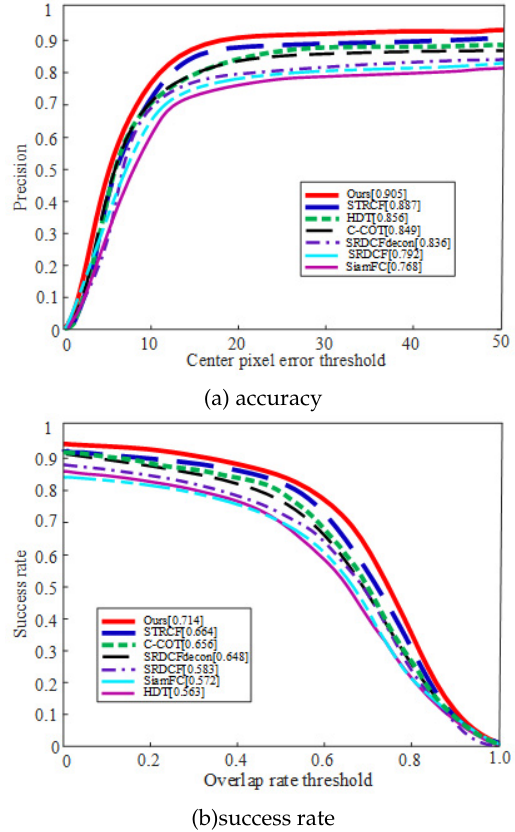
Fig. 5. Comparison curve of average accuracy and average success